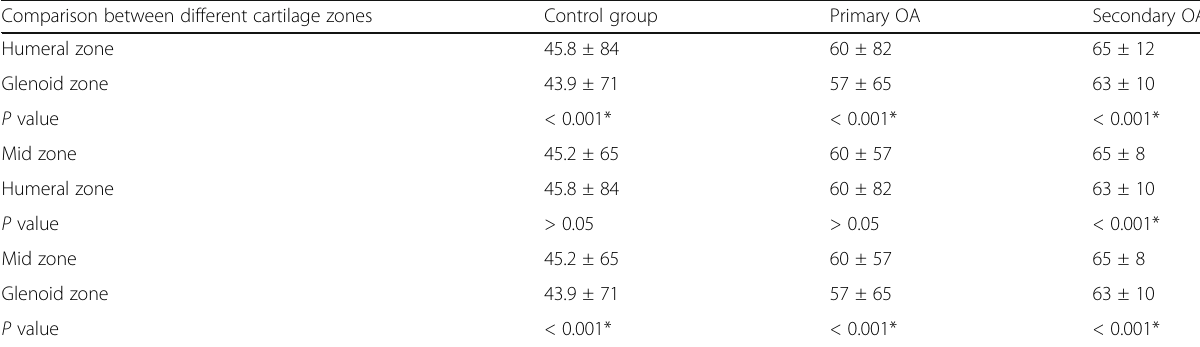
Table 2 Mean T2 mapping zonal variations in different cartilage compartments among the healthy subject and patients with primary and secondary osteoarthritis Comparison between different cartilage zones Control group Primary OA Secondary OA Humeral zone 45.8 ± 84 60 ± 82 65 ± 12 Glenoid zone 43.9 ± 71 P value < 0.001* Mid zone Humeral zone Mid zone 45.2 ± 65 60 ± 57 65 ± 8 Glenoid zone 43.9 ± 71 P value <